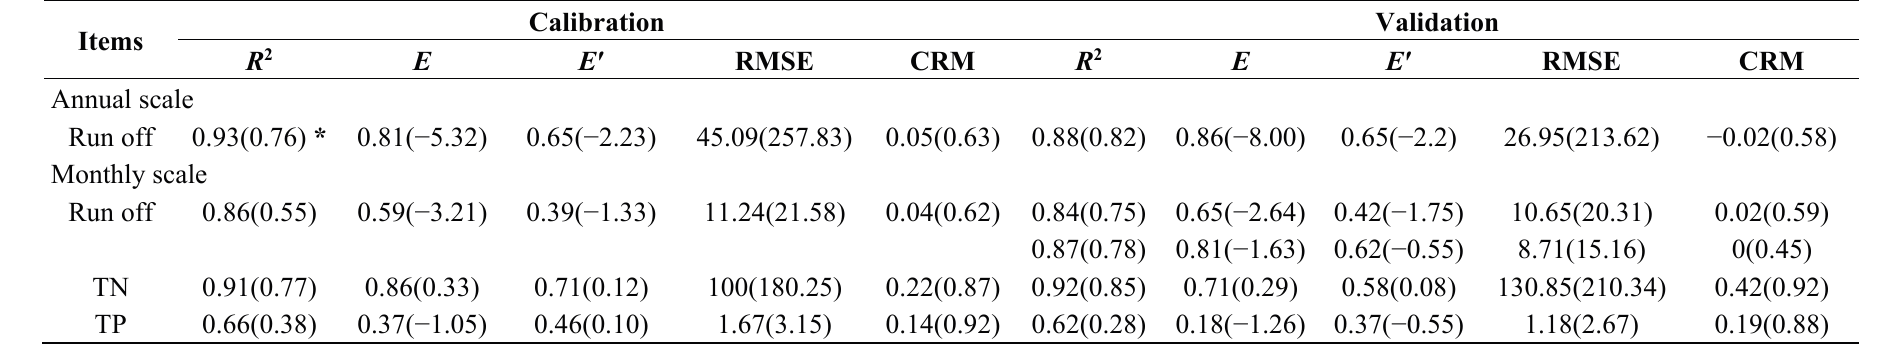
Table 4. Estimated statistical parameters of model performance for default and